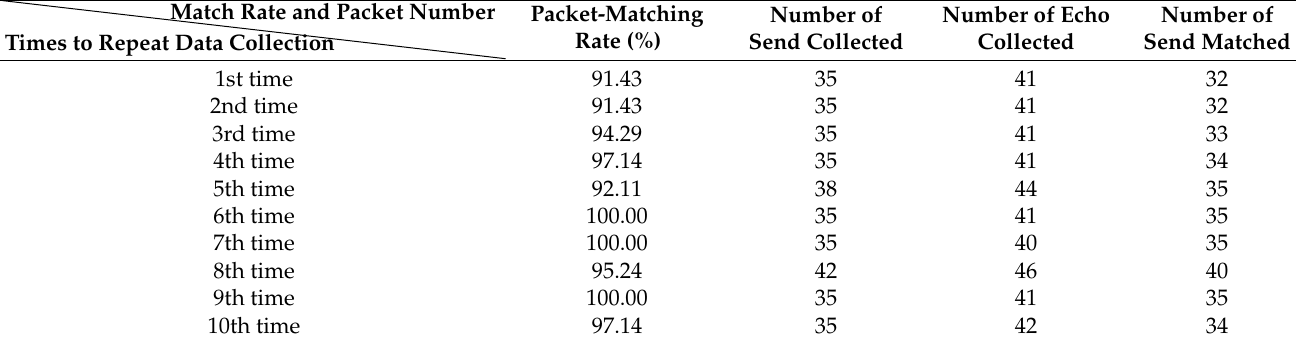
Table 4. Packet-matching rate in Five-Connection (average rate: